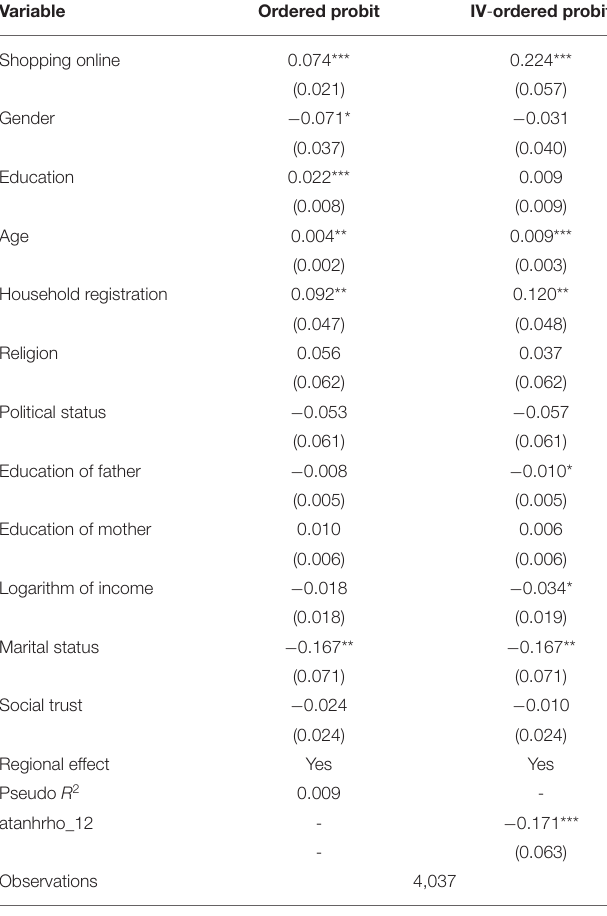
TABLE 4 | Robustness check ( N =